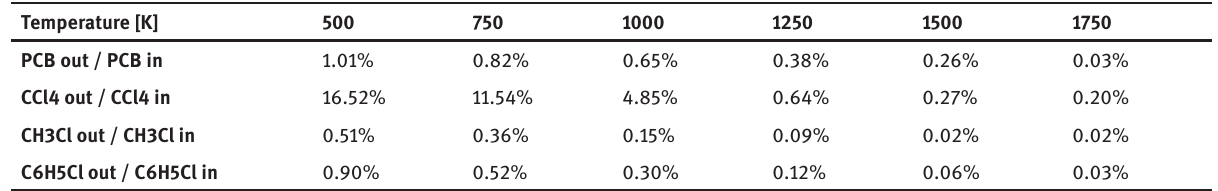
Table 1 : Table presenting percentage content of undecomposed chloroorganic compounds versus temperature [K].